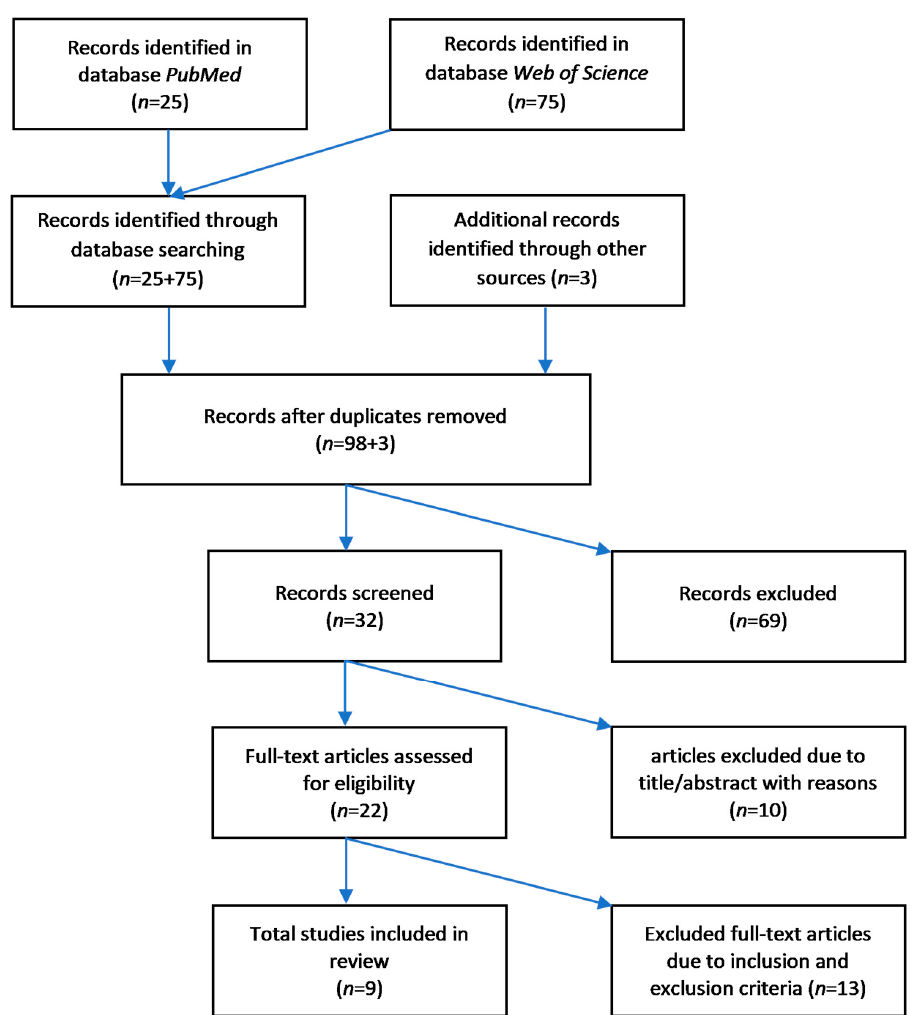
Figure 2. Flow chart of the inclusion process of studies used in this review. A total of n = 9 studies were finally included and considered for this review. Modified according to Moher et al. [28].